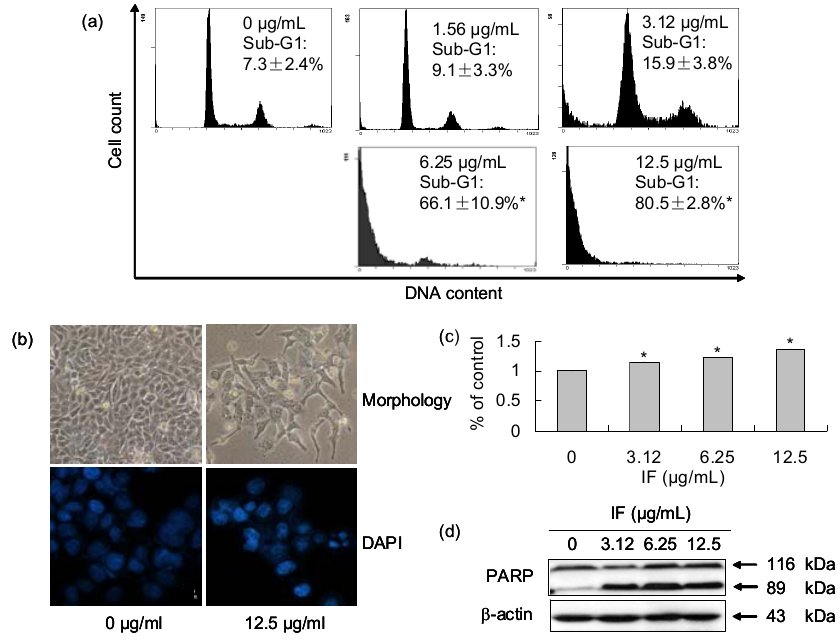
Figure 3. Apoptosis induction of IF in CNE cells at 72-h treatment. (a) Effect of IF on cell cycle distribution analyzed by flow cytometry. (b) Effect of IF on the morphology of CNE cells. Morphology (upper): phase-contrast microscopy. DAPI (lower): fluorescence microscopy. (c) Activation of caspase by IF. (d) IF induced PARP cleavage. Each value represents the mean of three independent experiments. Difference between treatments and control with p < 0.05 (*) was considered statistically